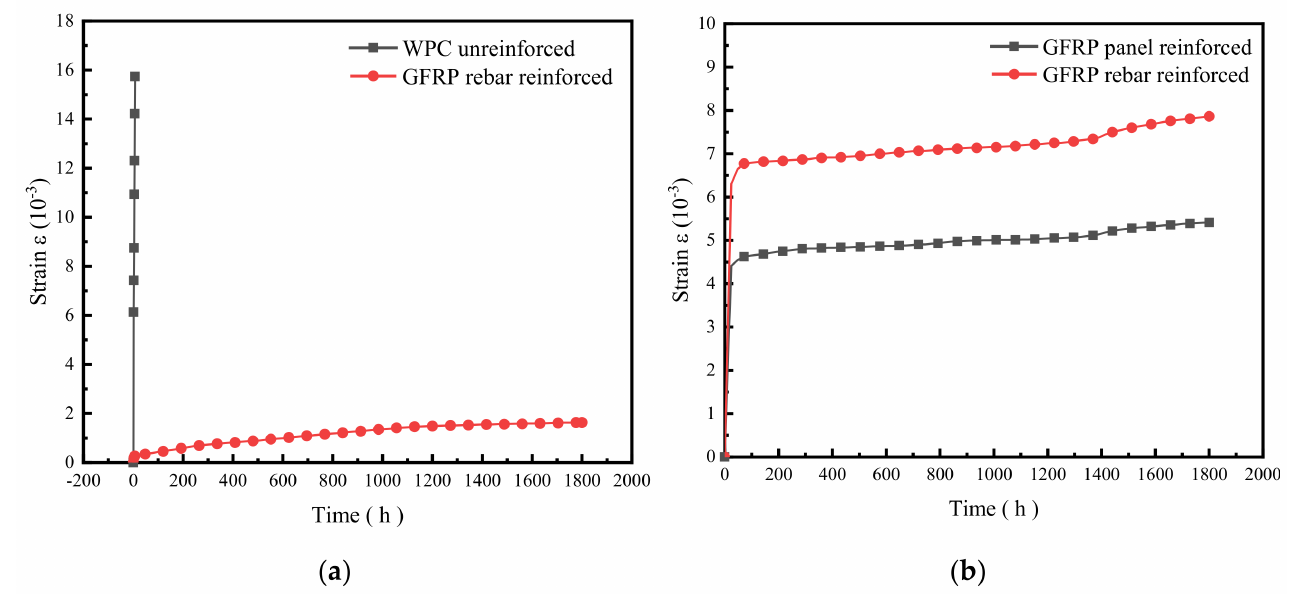
Figure 7. Comparison of bending creep strain–time curves of unreinforced and reinforced WPCs at the same load. ( a ) Strain comparison between unreinforced and reinforced with GFRP rebar specimens (load 1400 N). ( b ) Strain comparison between GFRP-sheets- and rebar-reinforced specimens (load 3600